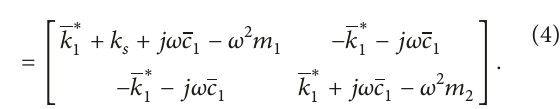
Figure 4: Equivalent simplified model in the 𝑥 direction.